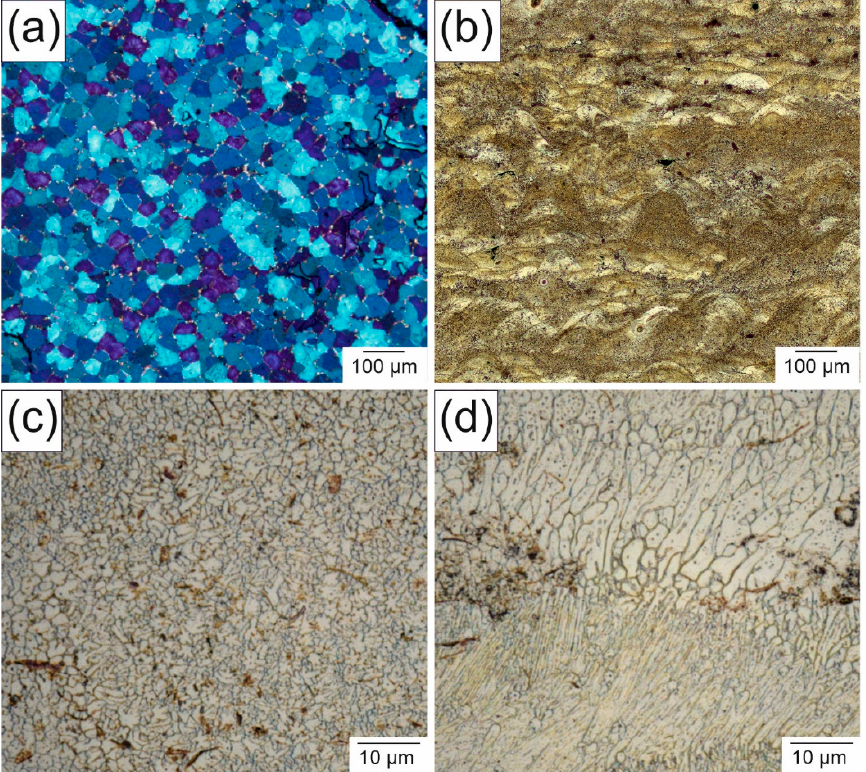
Figure 4. Light microscopy images of the microstructure of WE43: ( a ) as-cast, ( b ) PBF-LB-generated and ( c , d ) detailed images of different spots in ( b ).